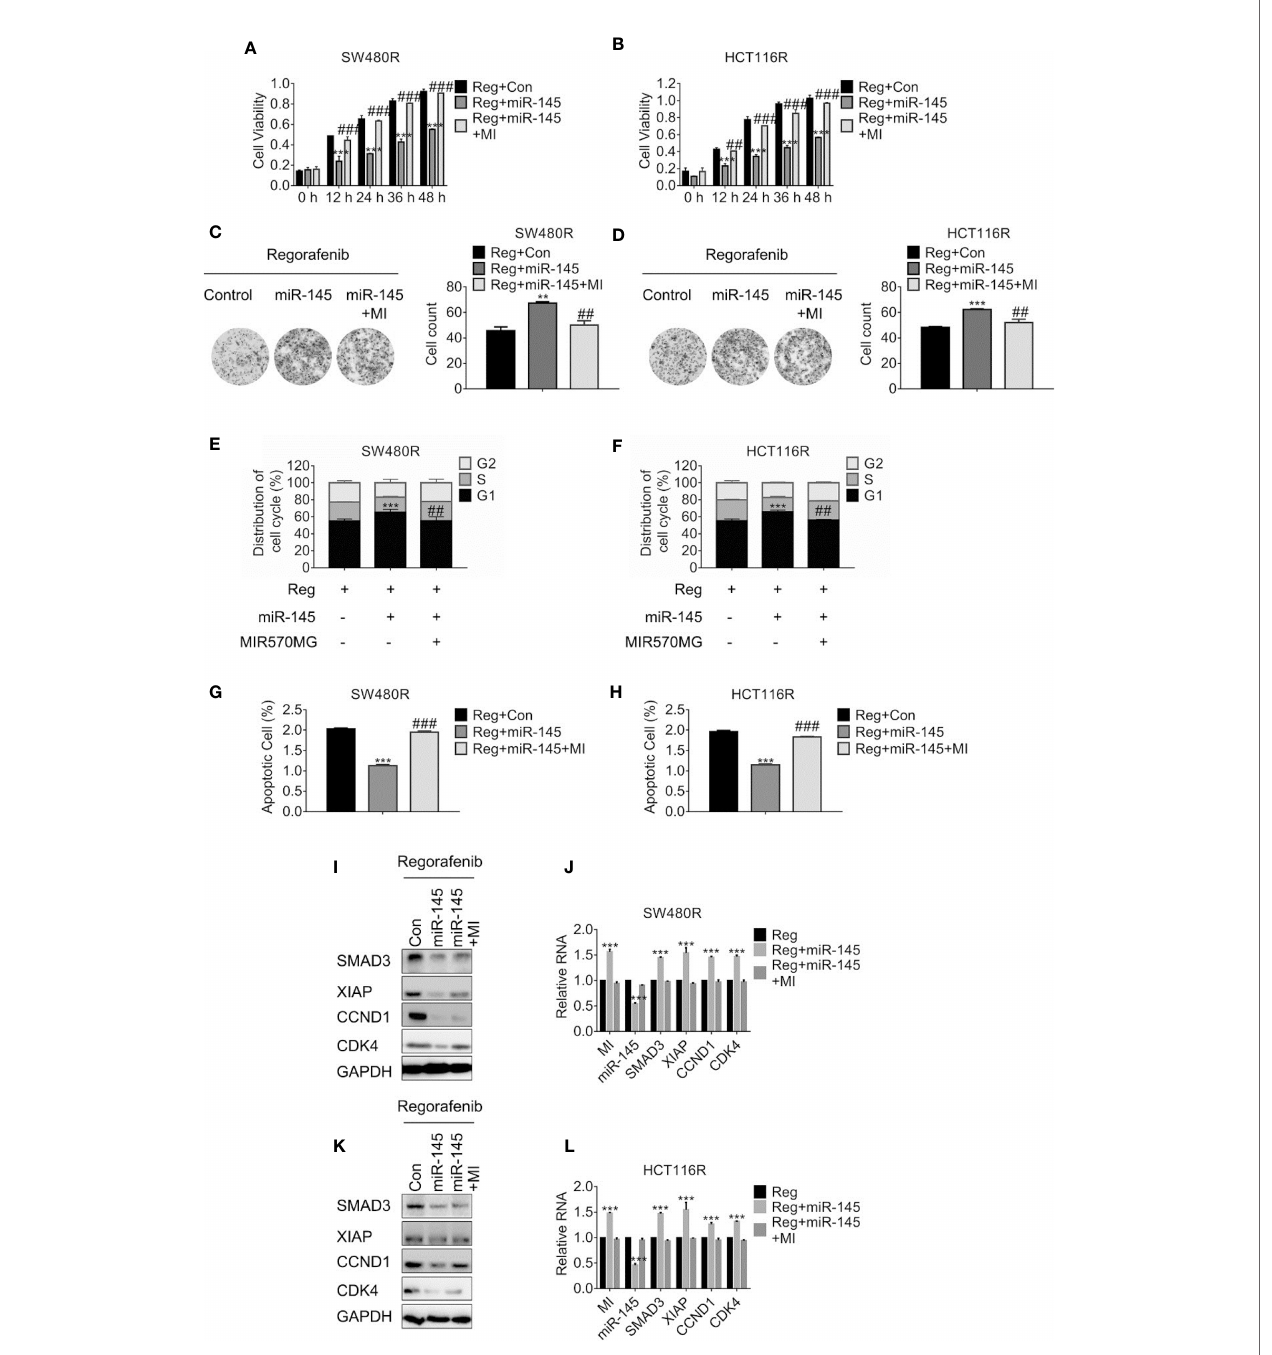
FIGURE 5 | MIR570MG confers resistance against regorafenib by releasing SMAD3 from miR-145. (A, B) Cell viability of SW480R and HCT116R was accessed by MTT assay. Cells expressing miR-145 or miR-145 plus MIR570MG were treated with Regorafenib. MTT assay was conducted post-treatment at different time- points. (C, D) Colony formation of SW480R and HCT116R was performed post-regorafenib treatment. Cells were transfected with MIR570MG or the combination prior to regorafenib treatment. (E, F) Distribution of cell cycle of the indicated cells were analyzed by fl ow cytometry. Cells expressing miR-145 or the combination were exposed to 1 m M regorafenib for 24 h prior to fl ow cytometry analysis. (G, H) Apoptosis of SW480R and HCT116R was measured post-regorafenib treatment. Cells expressing miR-145 or combination were exposed to 1 m M regorafenib for 24 h. JC-1 assay was performed, followed by fl ow cytometry analysis post- treatment. The expression of the indicated genes in SW480R (I, J) and HCT116R (K, L) cells were measured by Western blot and qRT-PCR, separately. **P < 0.01, ***P < 0.001, vs. control exposed to regorafenib; ## P < 0.01, ### P < 0.001, vs. miR-145 exposed to regorafenib. Data obtained from three independent experiments. MI, MIR570MG; Reg, 1 m M regorafenib